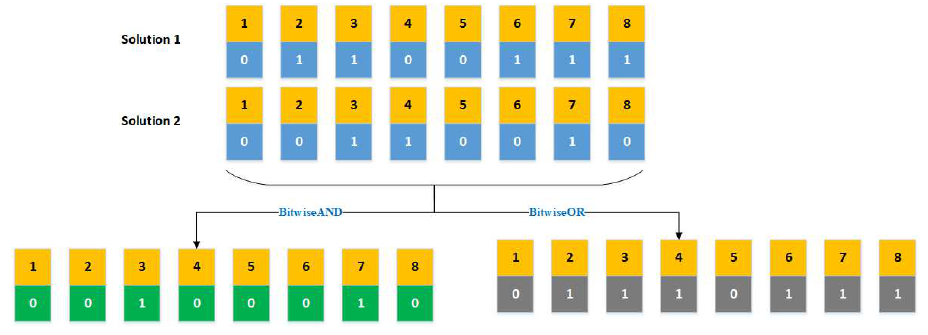
Figure 9. Bitwise Operators (AND,